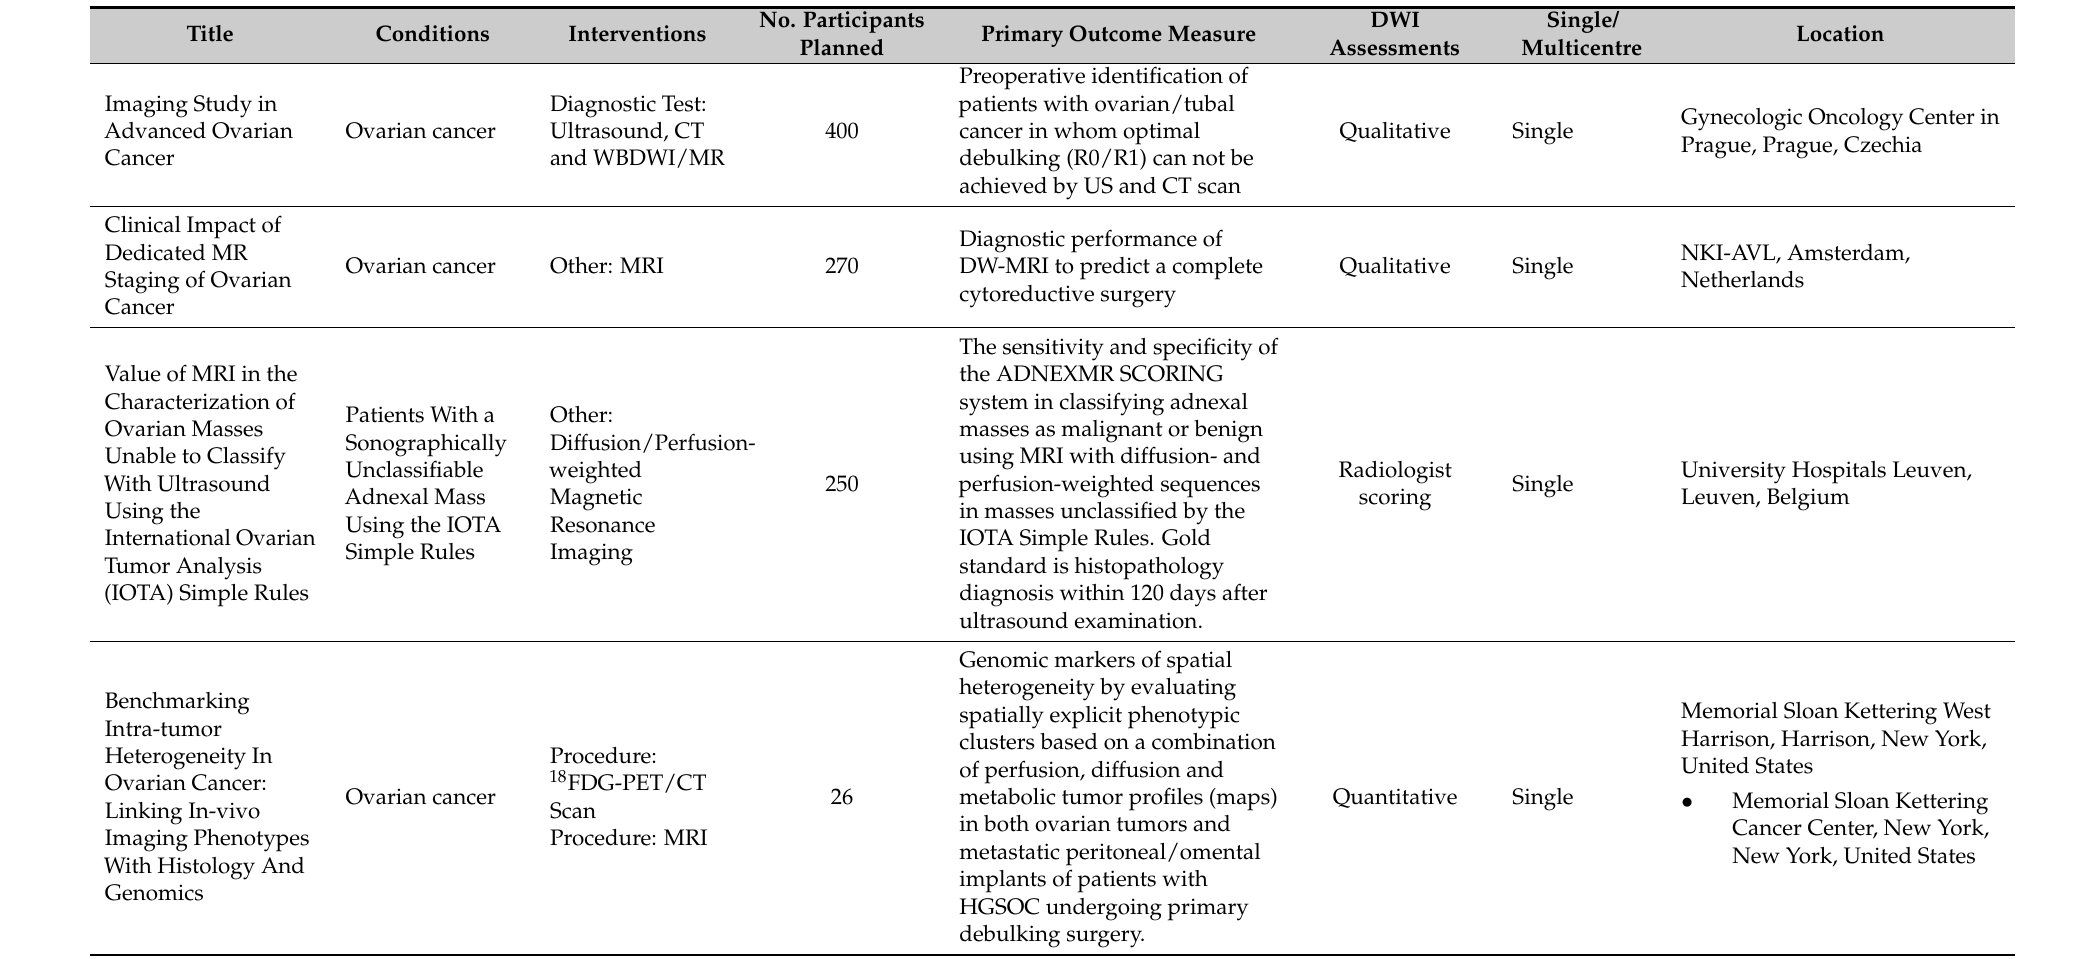
Table 3. Clinical trials incorporating DW-MRI listed on